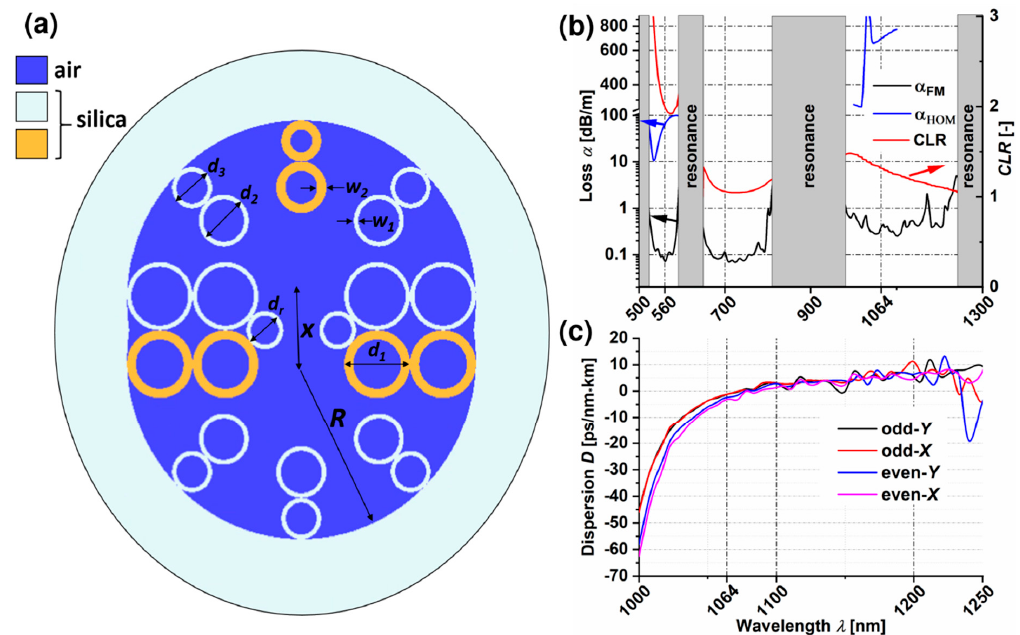
Figure 2. ( a ) Cross section of the DHC-ARF; the descriptions and values of the dimensions can be found in the main text. The cross-section is rotated by 90° when compared to the one presented in Figure 3. ( b ) The highest losses of the fundamental modes ( α FM , black curve), the lowest losses of the higher order modes ( α HOM , blue curve) and the coupling length ratio ( CLR , red curve) with respect to the wavelength. The arrows indicate the Y -axis corresponding to the pointed curve. ( c ) Dispersion D versus wavelength of the four fundamental core modes with different orthogonal polarizations (- Y or –X ) and parity (even or odd) in the 3rd antiresonant window of the proposed DHC-ARF. For λ ex = 1064 nm one can see that D ϵ < 0, 5 > ps/nm × km, making it a negligible value for the multiphoton fluorescence-based diagnostic setups.